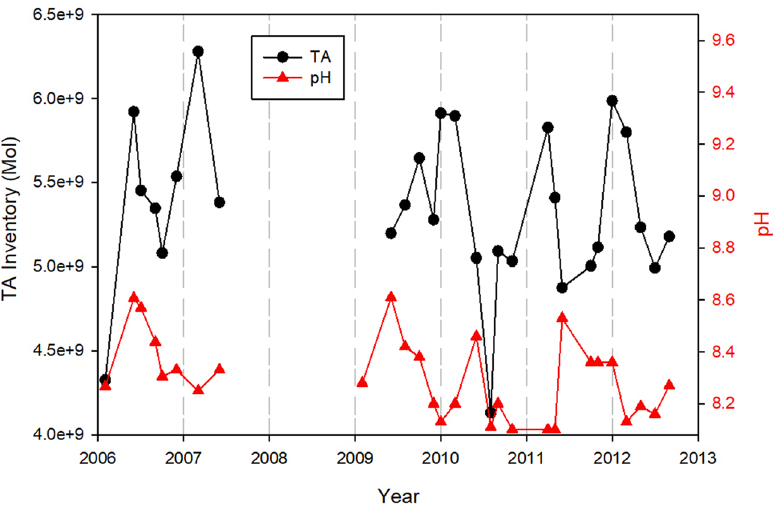
Figure 6. Seasonal and inter-annual changes in maximum pH and inventory of total alkalinity in Florida Bay over the period of